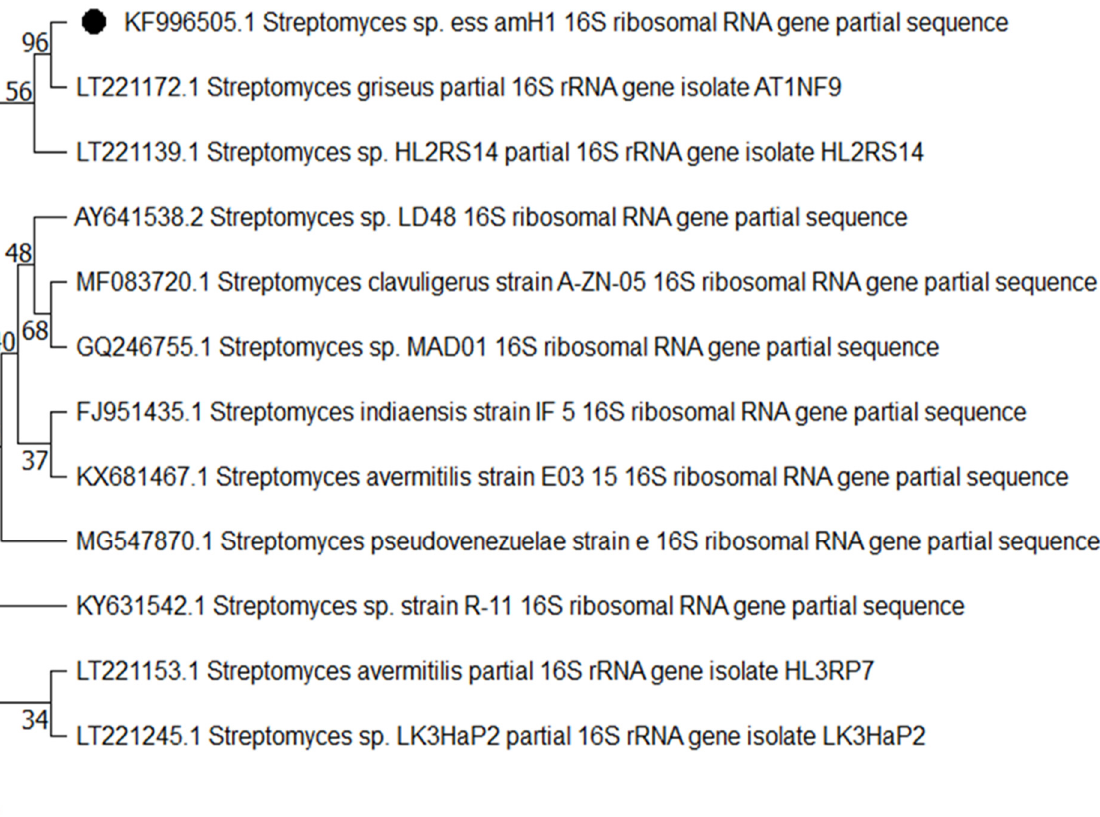
Table 6. Compound analysis by GC–MS for EtOAc extract of Streptomyces sp. strain ess_amH1. S. No